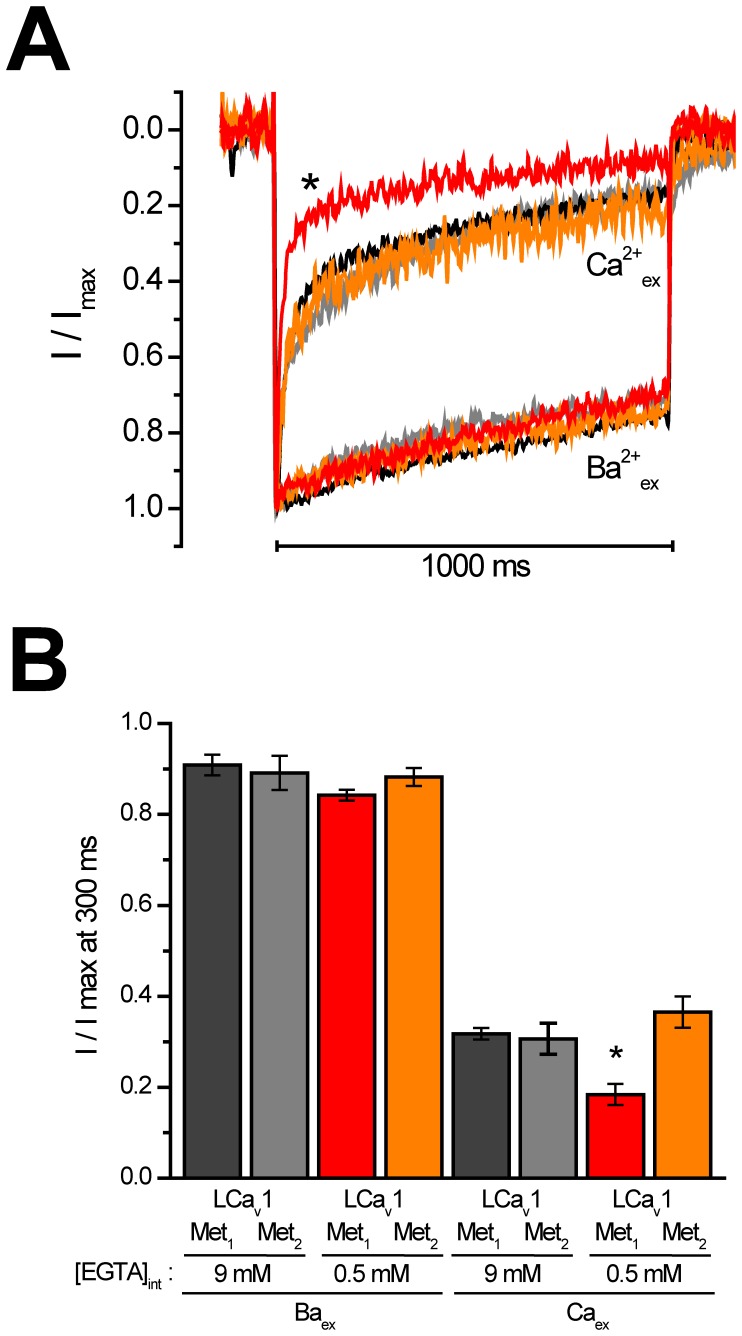
Full-length LCav1-Met1 channels containing NSCaTE have a buffer-sensitive form of calcium dependent inactivation not found in truncated LCav1-Met2 channels lacking NSCaTE.LCav1-Met1 and LCav2-Met2 were transfected in HEK-293T cells alongside mammalian α2δ1 and β2a accessory subunits and recorded using patch clamp electrophysiology. (A) Overlapping sample traces illustrating the ultra-fast calcium-dependent inactivation (red trace) of LCav1-Met1 channel currents in low (0.5 mM) EGTA buffering conditions. (B) Graph of fraction of peak current size at 300 ms time point of inactivation decay (R300). * represents a statistically significantly smaller R300 value (p<0.001, ANOVA) for LCav1-Met1 calcium currents (red trace), reflecting the buffer-sensitive calcium dependent inactivation uniquely in LCav1 channels with a full N-terminus, containing NSCaTE.